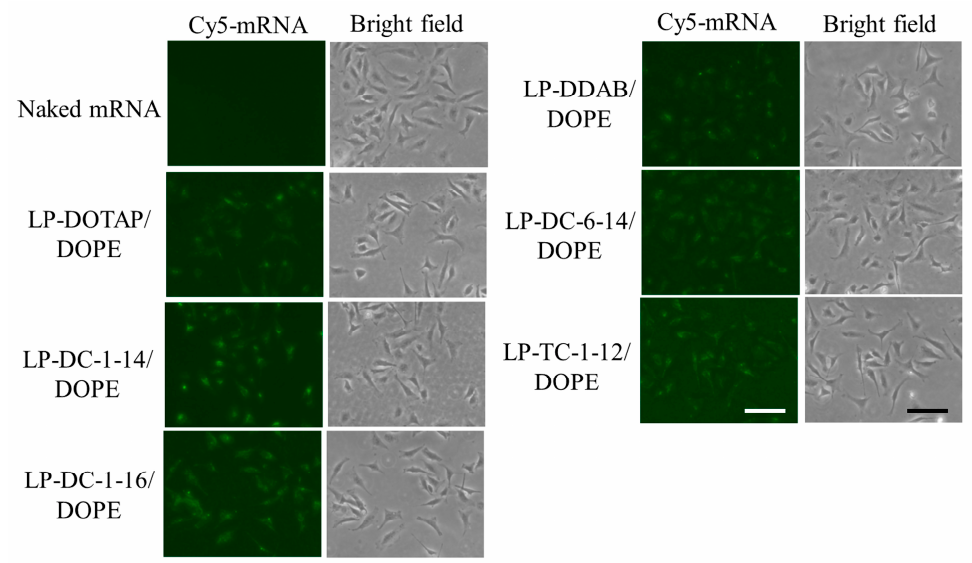
Figure 4. Effect of cationic lipids in mRNA lipoplexes on cellular uptake in HeLa cells after trans- fection with Cy5-mRNA lipoplexes. mRNA lipoplexes with Cy5-mRNA were added to HeLa cells at 0.5 µg/mL mRNA, and localization of Cy5-mRNA (green) was observed 3 h after incubation. Scale bar = 100 µm.